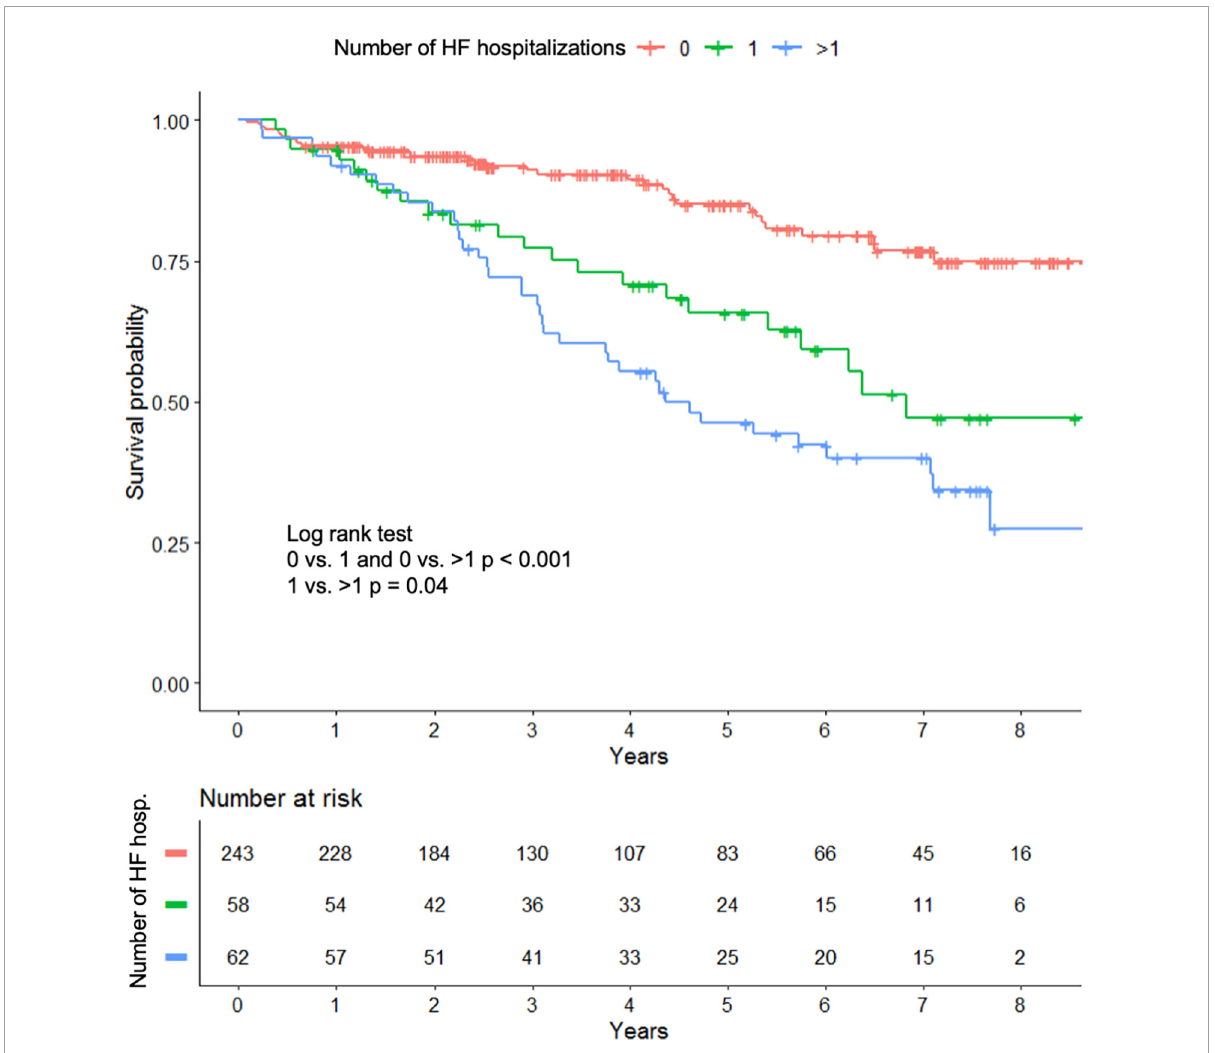
FIGURE2 Kaplan–Meier curves for all cause death in patients with heart failure hospitalization and stable